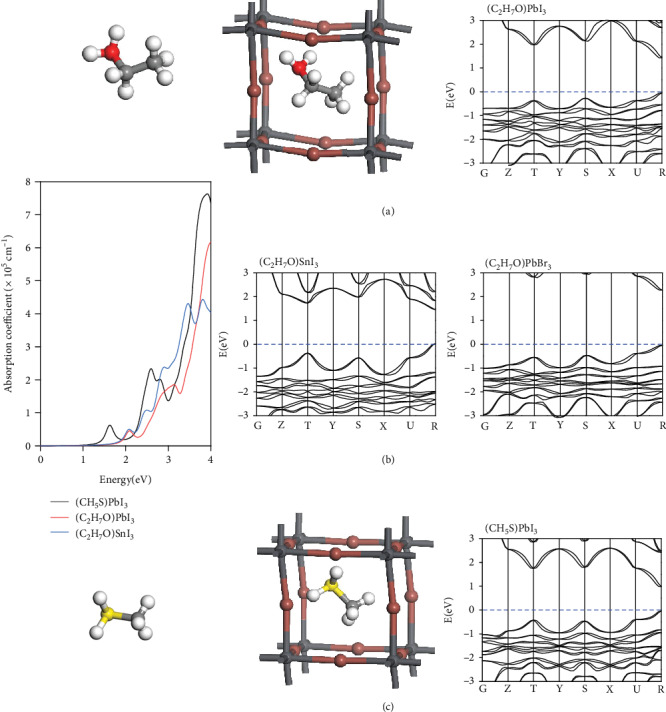
(a) Structure of C2H5OH2+ cation and related HOIPs and the band structures of HOIPs. (b) Computed optical absorption spectra of (CH5S)PbI3, (C2H5OH2)PbI3, and (C2H5OH2)SnI3. (c) Structures of CH3SH2+ cation and (CH3SH2)PbI3 and the band structures of (CH3SH2)PbI3.